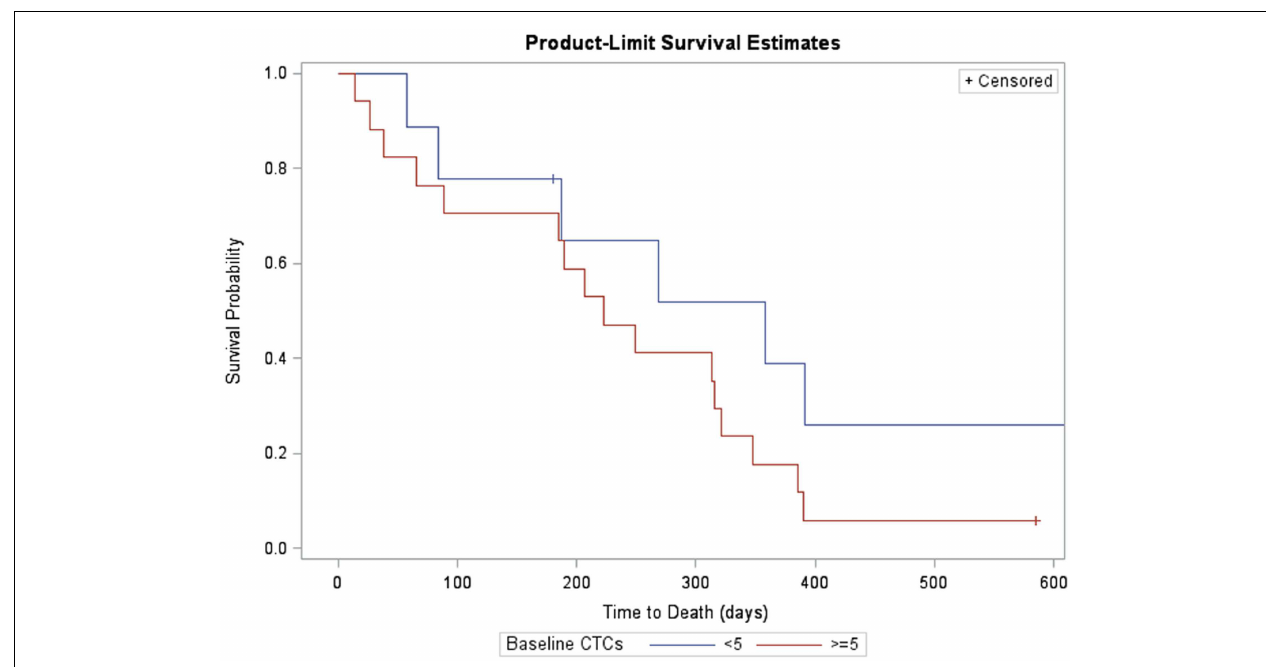
average, 223days (95% CI: 65, 321). Subjects with < 5 CTCs at baseline had median survival of 358days (95% CI: 58, 358). Differences in survival were significant at the 10% level (log-rank χ 2 = 1.99, p =